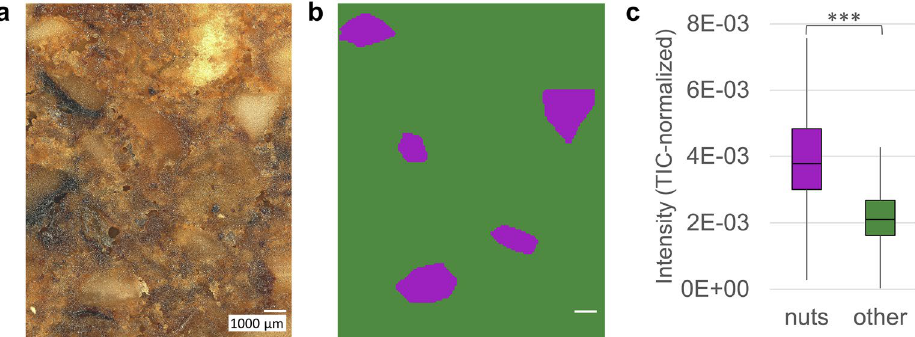
Figure 4. Acrylamide intensity distribution on German gingerbread. ( a ) microscope image of German gingerbread section. ( b ) Surface stratification into regions of interest (ROI) “nuts” based on sum image of triglycerides TG 52:3, TG 52:4, TG 54:5, TG 54:6 and TG 57:10 and “other”; more details are provided in Fig. S3. Export of abundance data of acrylamide m/z 72.04439 ± 2.5 ppm for both ROI. ( c ) Boxplot of backtransformed intensity values stratified into ROI “nuts” and “other”; two-sided t-Test was performed on x 0.25 -transformed intensity values; *** t(247) = 16.93, P <